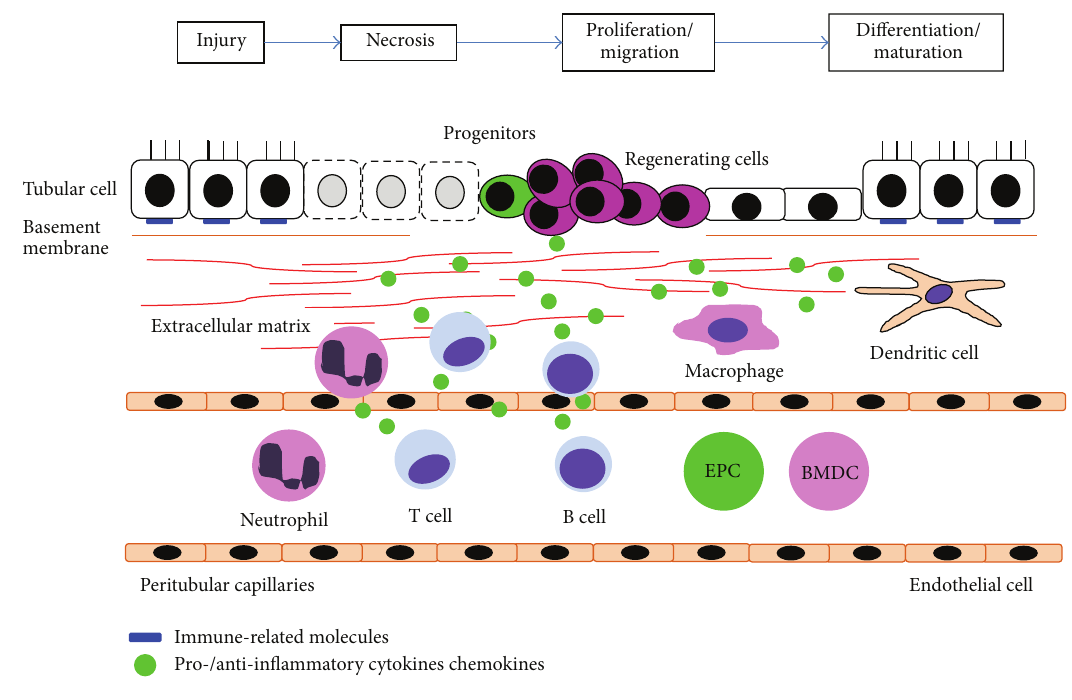
Figure 1: Diverse cell populations involved in tubular regeneration after